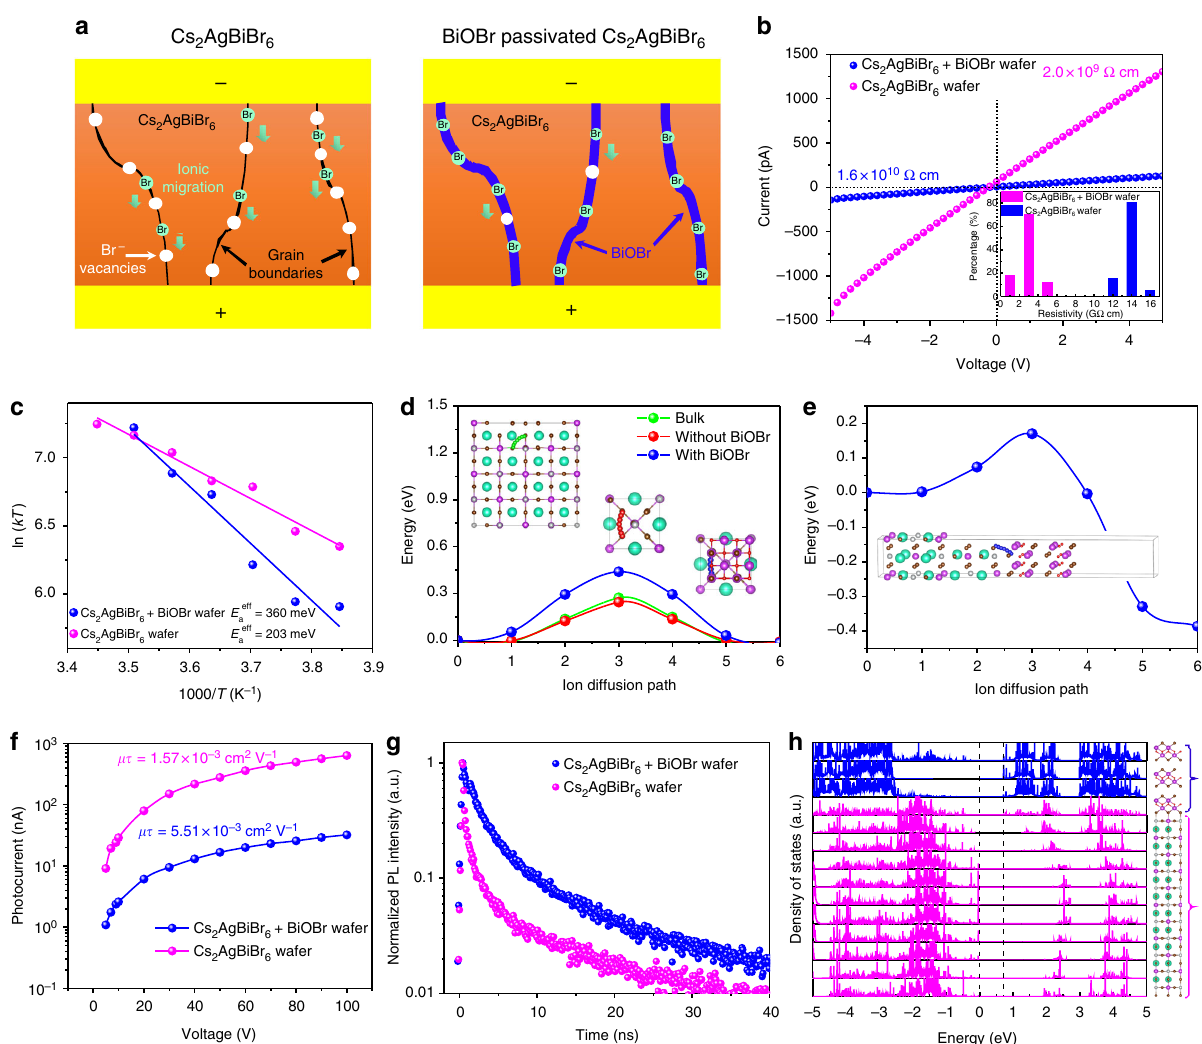
Fig. 3 Optical and electrical properties of Cs 2 AgBiBr 6 wafers with/without BiOBr passivation. a Schematic illustration of the suppressed ionic migrations by BiOBr passivation. b The resistivity of the wafers and the inset is the statistical result. c Arrhenius plots of the temperature dependence of kT versus 1000/ T , while k is the ionic migration rate (s − 1 ) and is proportional to the ionic conductivity. The fi tting curve gives the activation energy of ionic migration, also known as the ion diffusion barriers. d Calculated energy pro fi le along the ionic migration path for V Br (Br − vacancies) in bulk Cs 2 AgBiBr 6 , in-plane migration for surface of Cs 2 AgBiBr 6 without and with BiOBr passivation. Inset: migration path of V Br with the Br − highlighted in green (bulk), red (surface without BiOBr passivation), and blue (surface with BiOBr passivation) color, respectively. e Calculated energy pro fi le of the out-of-plane ionic migration path for the − highlighted in green, and the V V Br in BiOBr-passivated Cs 2 AgBiBr 6 . Inset: Migration path of V Br with the Br Br migration direction is from BiOBr to Cs 2 AgBiBr 6 . f Bias-dependent photoconductivity of the wafers and the derived μτ value. g The time-dependent photoluminescence of the wafers. h Layered decomposed density of states for Cs 2 AgBiBr 6 /BiOBr